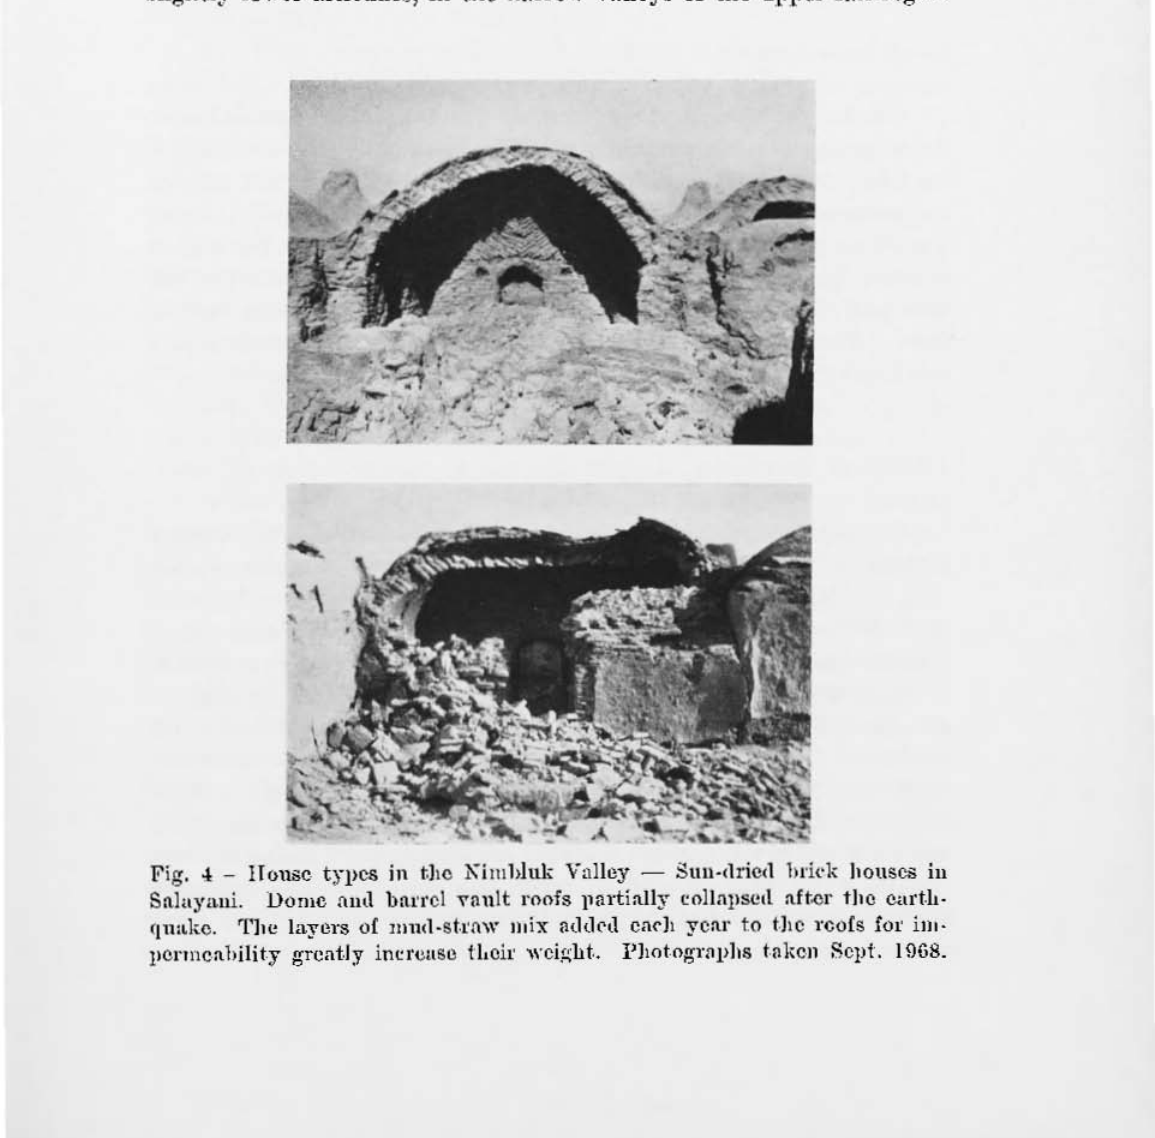
Fig . .. - lIouiiC tyl'cs in ,·IH) Kimhluk Valloy - Sun·dried hrit-k houscs